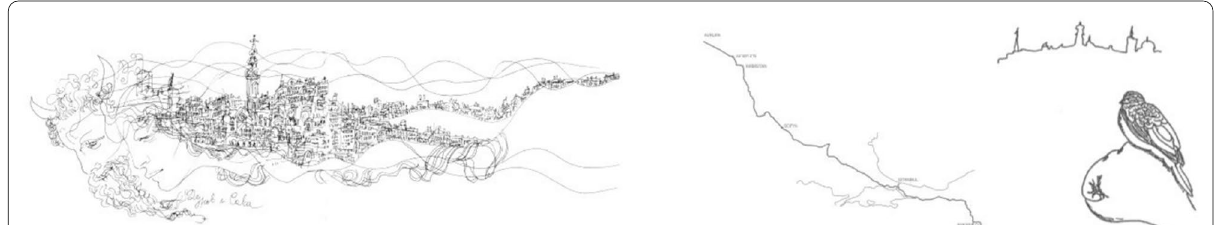
Fig. 4 Experience of the urban whole of Belgrade city—inhabitant (left) and visitor (right)